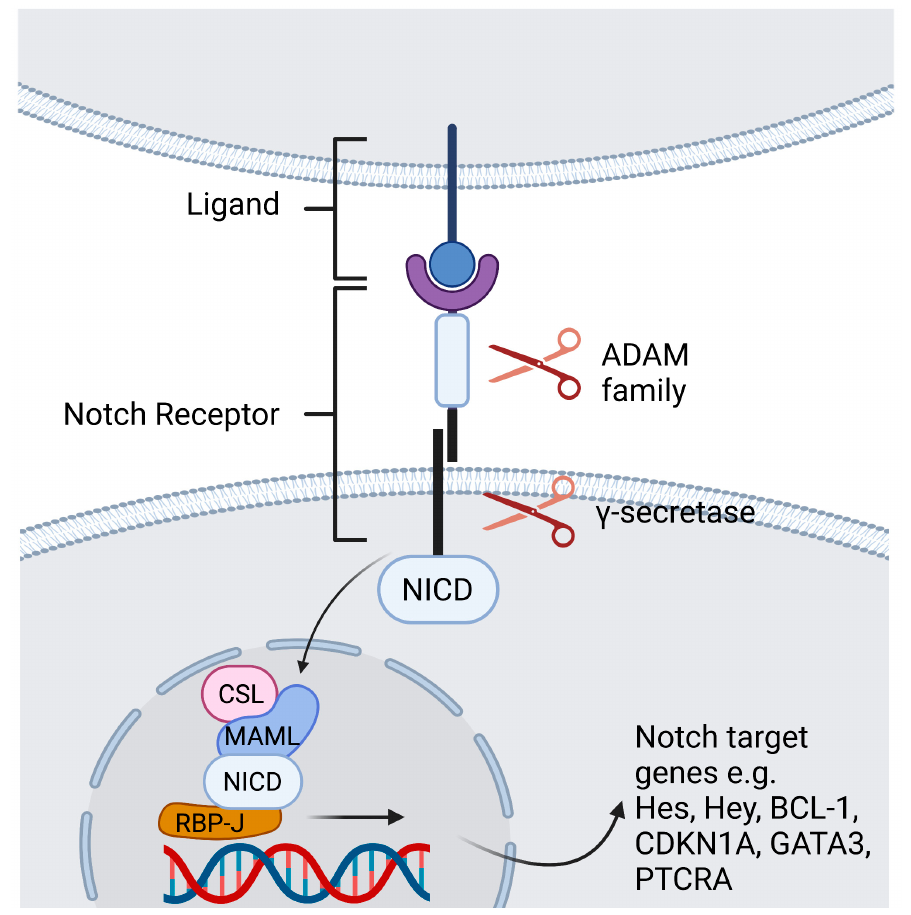
Figure 1. Contact dependent Notch signaling between cells. Ligand binding leads to a conformational change of the receptor. The first cleavage is arbitrated by the ADAM -family which leads to shedding of the extracellular domain. The second cleavage takes place inside the transmembrane domain and is catalyzed by a γ -secretase complex, that discharges the NICD to translocate to the nucleus. Within the nucleus, the NICD binds the DNA-binding protein RBP-J. Binding of NICD leads to transcription of the Notch target genes. Created with BioRender.com.